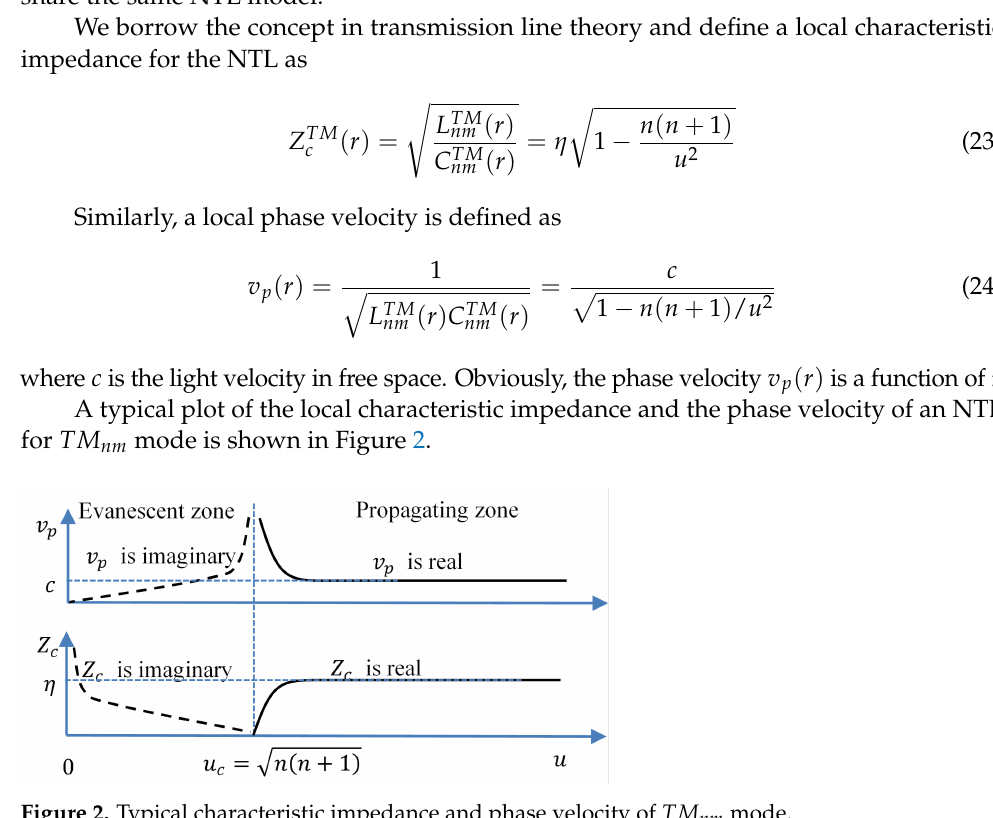
Figure 2. Typical characteristic impedance and phase velocity of TM nm